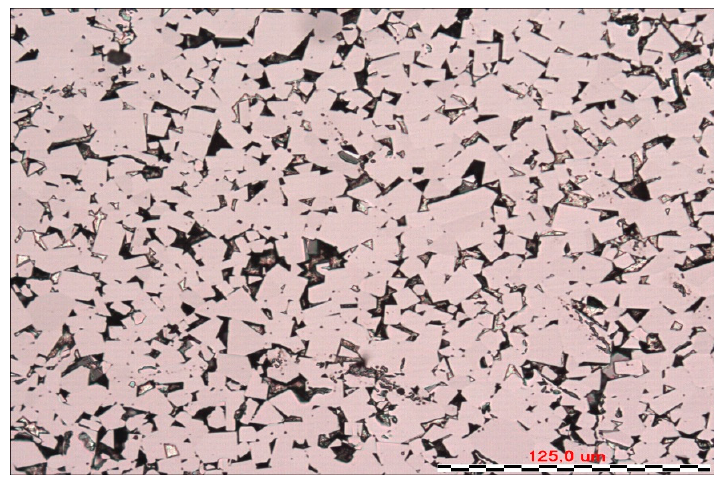
Figure 15. Microstructure of the tip made of sintered tungsten carbide–cobalt (WC-Co) of the conical pick for roadheaders (Figure 11a).